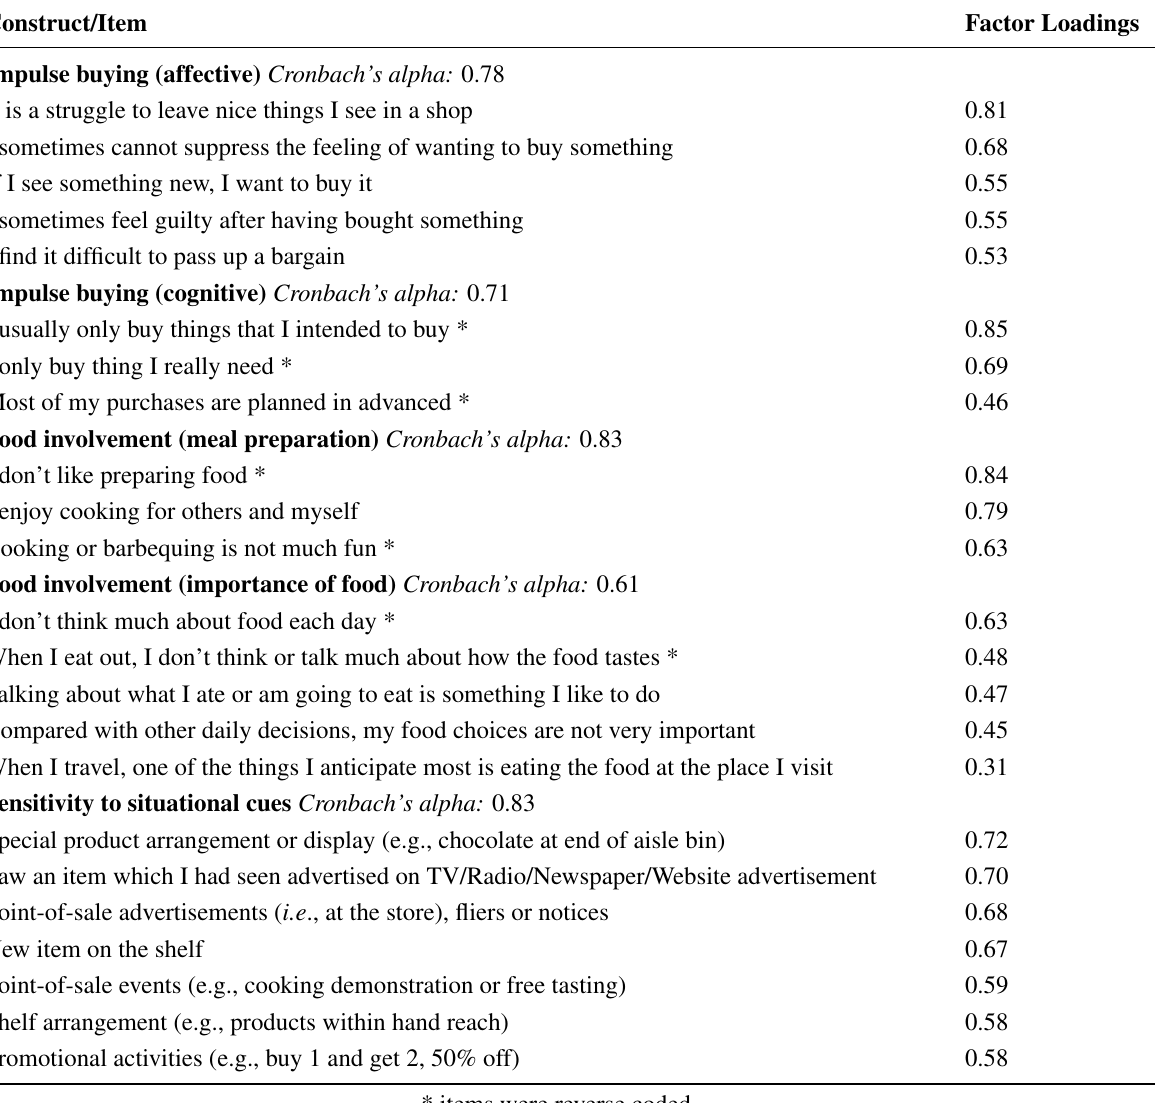
Table 2. Factor loadings and reliability estimates for measurement